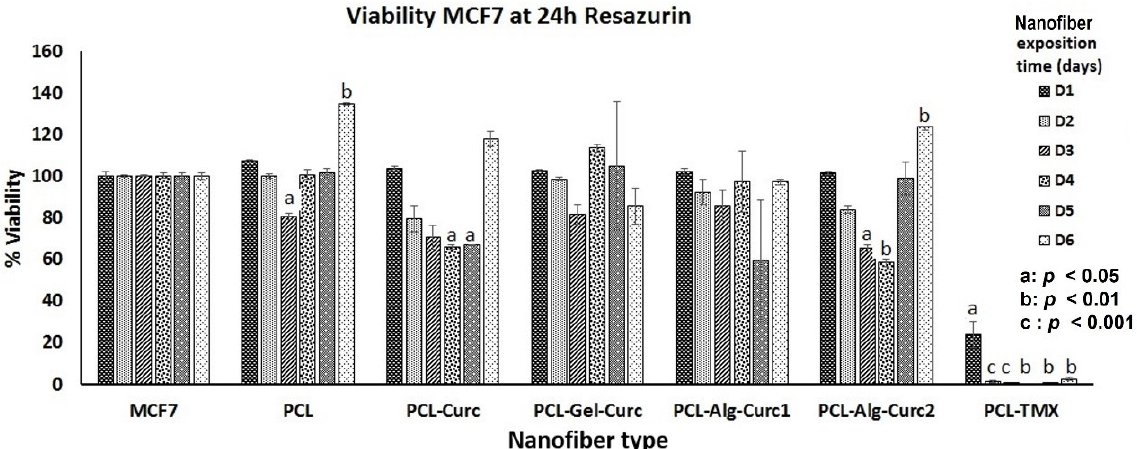
Figure 9. Viability percentage of MCF-7 cells treated with the different nanofibers for six days. The reduction in resazurin to resorufin was measured at 24 h. The student’s t -test was used to establish significance.